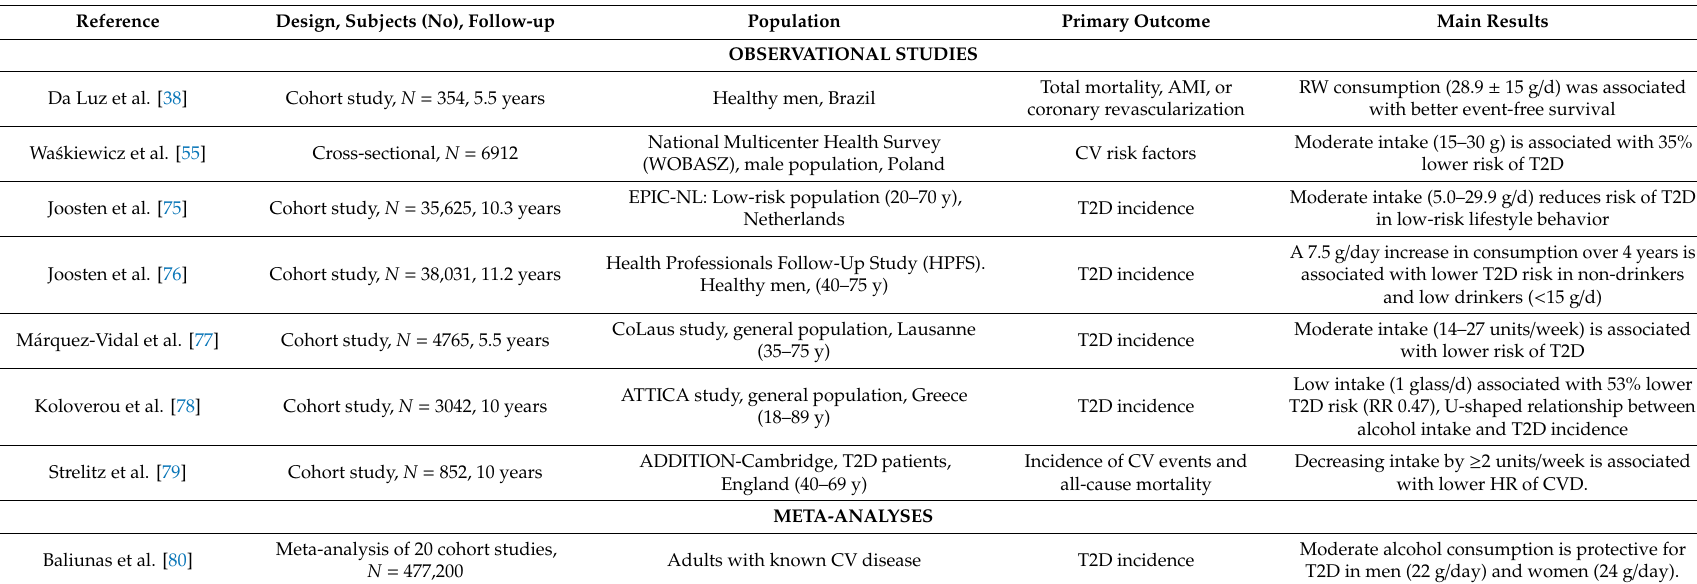
Table 4. Characteristics of eight studies evaluating the e ff ect of alcohol on Type 2